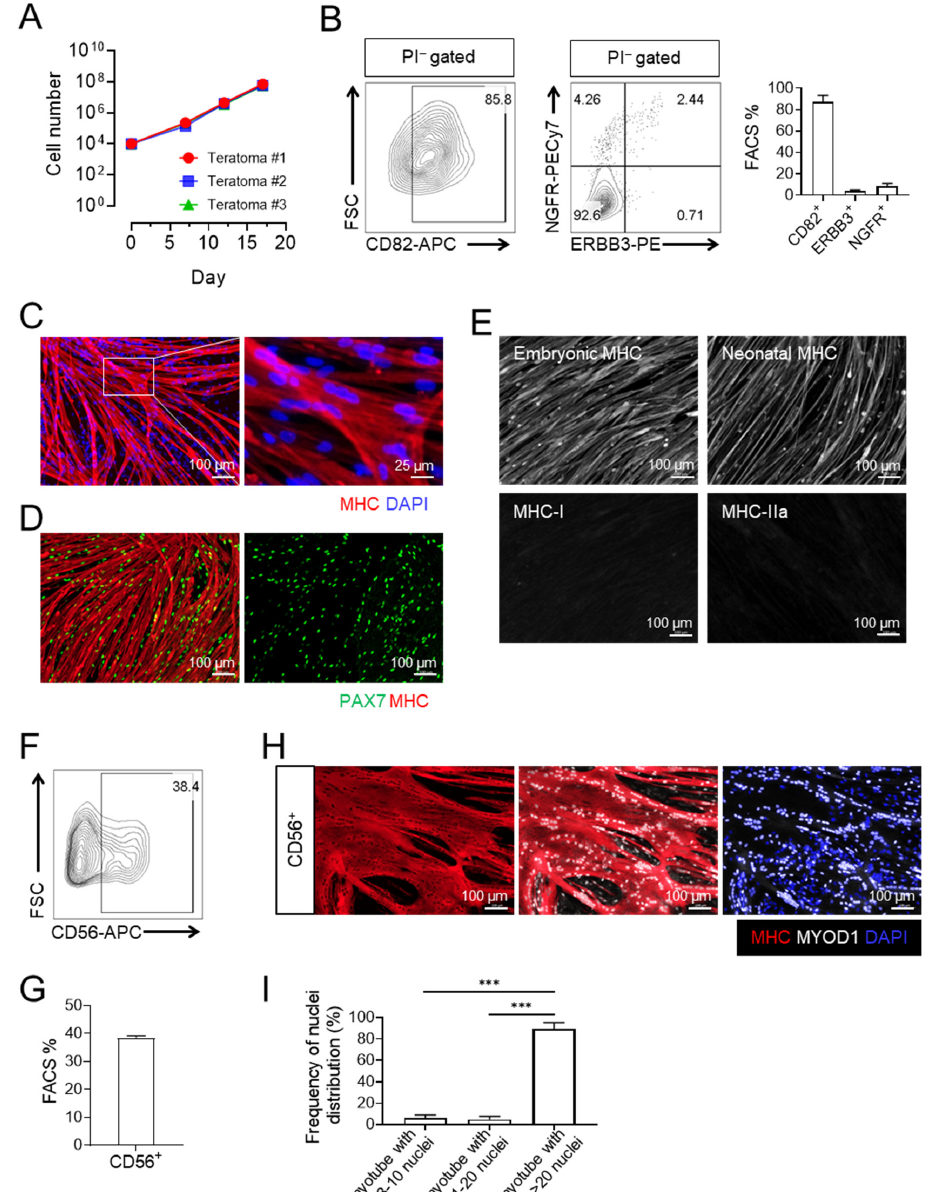
Figure 2. 8EN skeletal myogenic progenitors develop into CD56 + muscle stem cell-like cells in vitro. ( A ) Growth curves of 8EN cells from 3 different human H1 ESC-derived teratomas. ( B ) FACS anal- ysis and quantification of passage 3 8EN cells. Data are shown as mean ± SEM from 3 biological replicates. ( C , D ) Upon differentiation, passage 3 8EN cells developed into ( C ) MHC + myotubes (scale bar = 100 µ m left, 25 µ m right) and ( D ) PAX7 + “reserve cells” (scale bar = 100 µ m). ( E ) My- otubes generated from passage 3 8EN cells expressed embryonic and neonatal isoforms of MHC, but not the adult isoforms such as MHC-I and MHC-IIa (scale bar = 100 µ m). ( F ) FACS analysis of passage 3 8EN cells showing the emergence of a CD56 + cell population. ( G , H ) Passage 3 8EN-derived CD56 + cells fused into large multinucleated (>20 nuclei) MHC + myotubes ( G , scale bar = 100 µ m) and quantification of nuclei distribution ( I ). Data are shown as mean ± SEM from 3 biological replicates. *** p <0.001. 8EN: CD82 + ERBB3 + NGFR + ; MHC: myosin heavy chain.